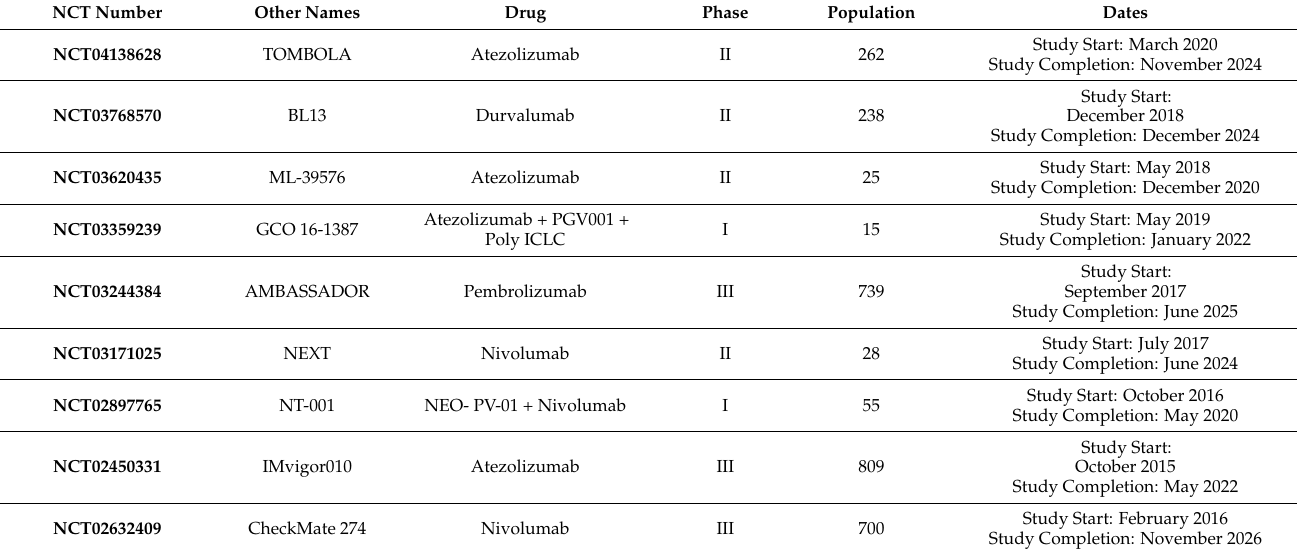
Table 2. Summary of ongoing clinical trials in adjuvant